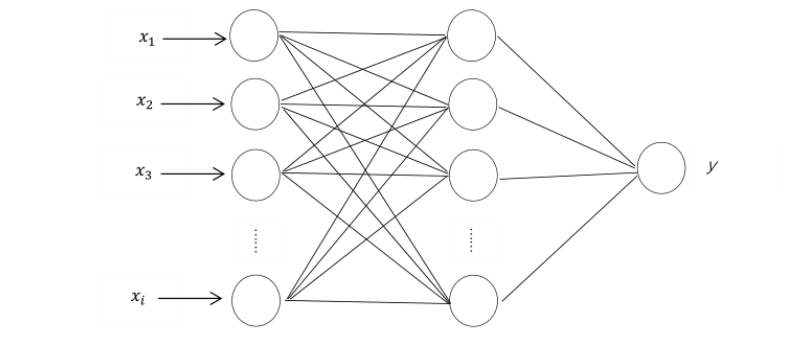
Figure 1. Neural network diagram.